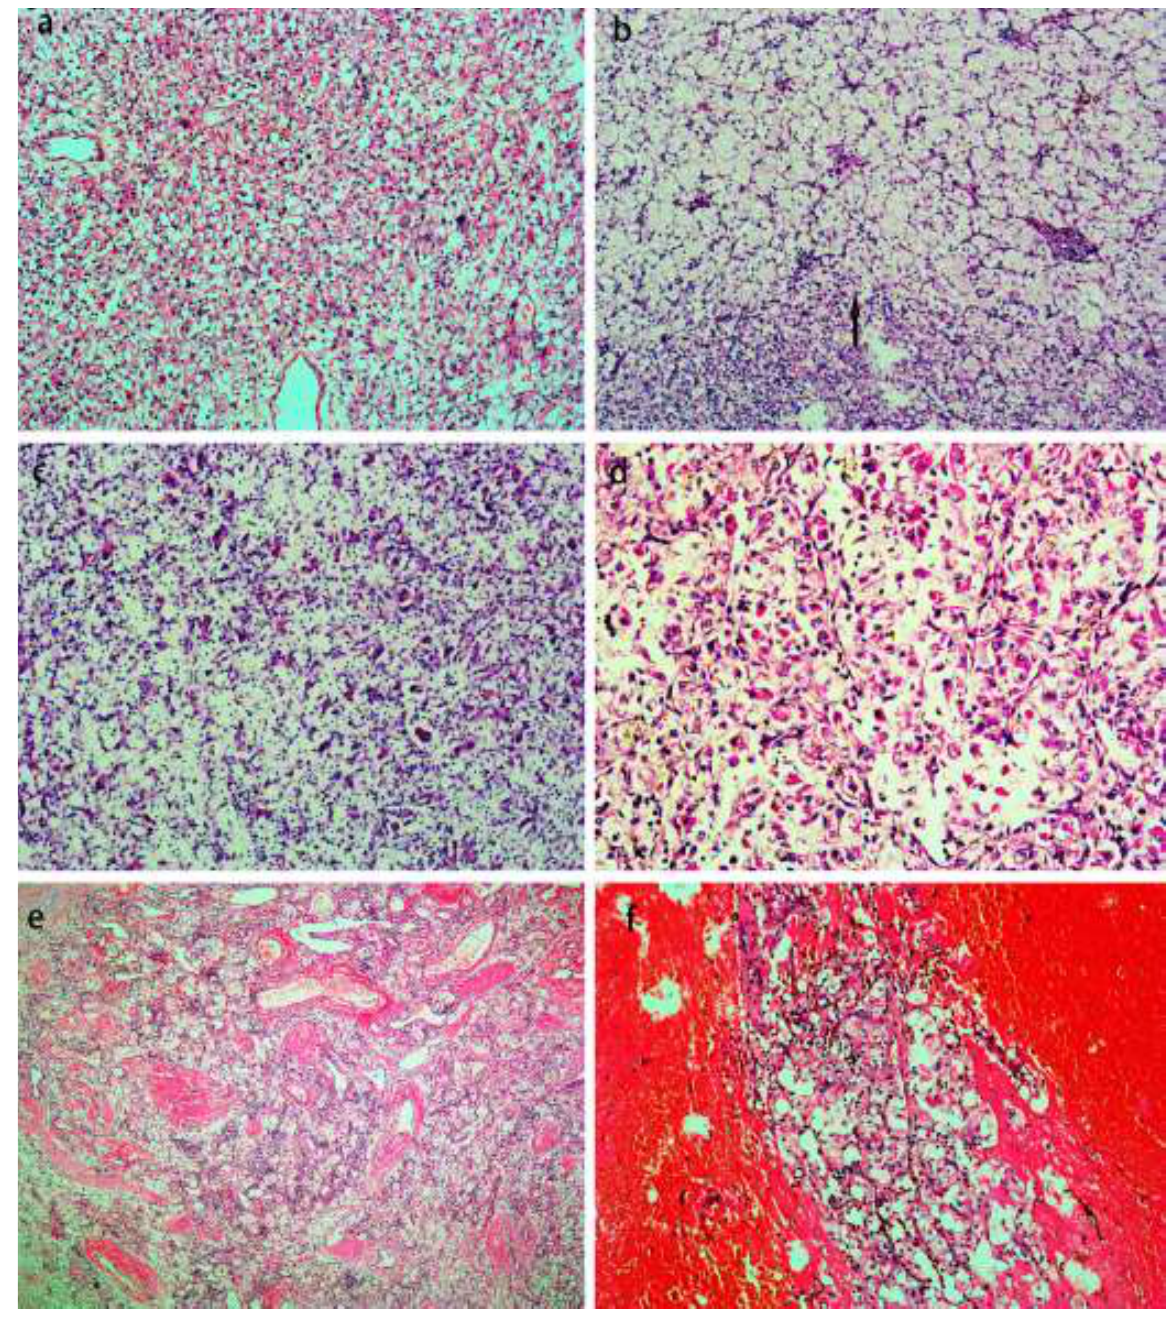
Figure 3. Morphologic spectrum of the TFEB rearranged RCC. ( a ). On higher power, tumors were composed of voluminous clear and/or eosinophilic cytoplasm cells, and the cells were polygonal with slightly distinct to distinct boundaries. ( b ). The cytoplasm of a few cells was similar that of the spherical band cells in adrenal cortical adenoma (arrowheads). ( c ). In case four, isolated eosinophilic cells were frequently observed and eosinophilic multinucleate cells were scattered in the clear tumor cells occasionally. ( d ). The rhabdoid features were present in only one tumor. ( e ). There were some thick-walled vessels scattered within or at the periphery of the tumors and local hyalinization was seen in blood vessel walls. ( f ). Focal fresh hemorrhage was also noted in the same